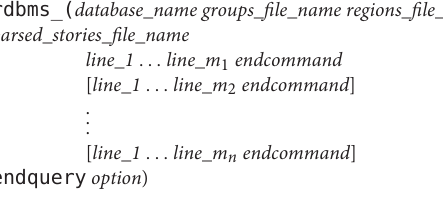
Figure 2 is central to this article’s main point: The id